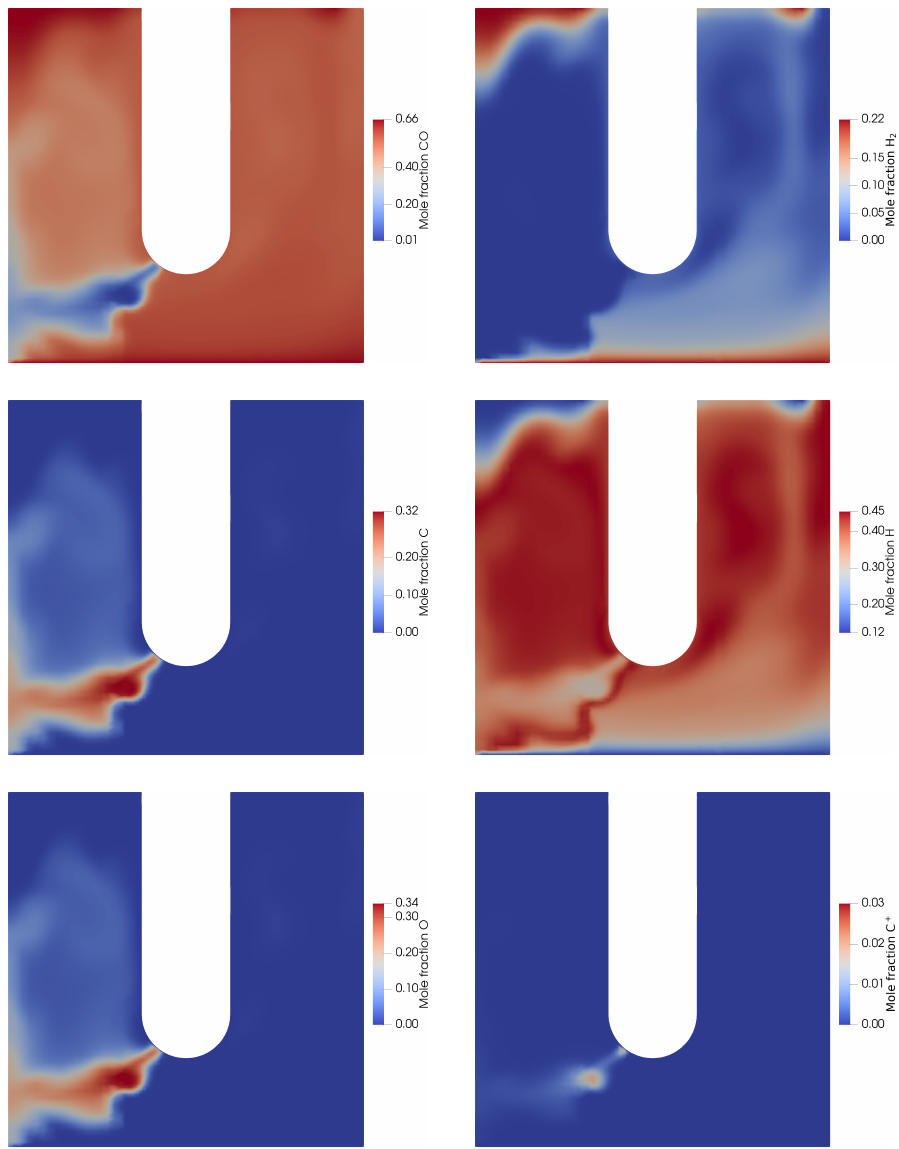
Figure 11. Plasma species concentration fields at 200 ms. x CO = 0.7, L a = 0.05 m and I = 1000